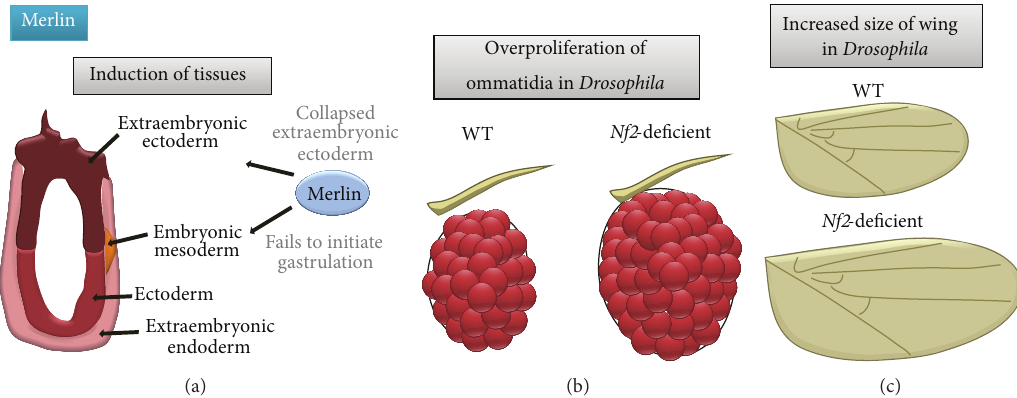
Figure 6: Merlin function during normal development. (a) Merlin is required for the induction of tissue layers during early embryonic development. In addition, merlin is essential for normal control of ommatidia proliferation (b) and (c) wing size in Drosophila